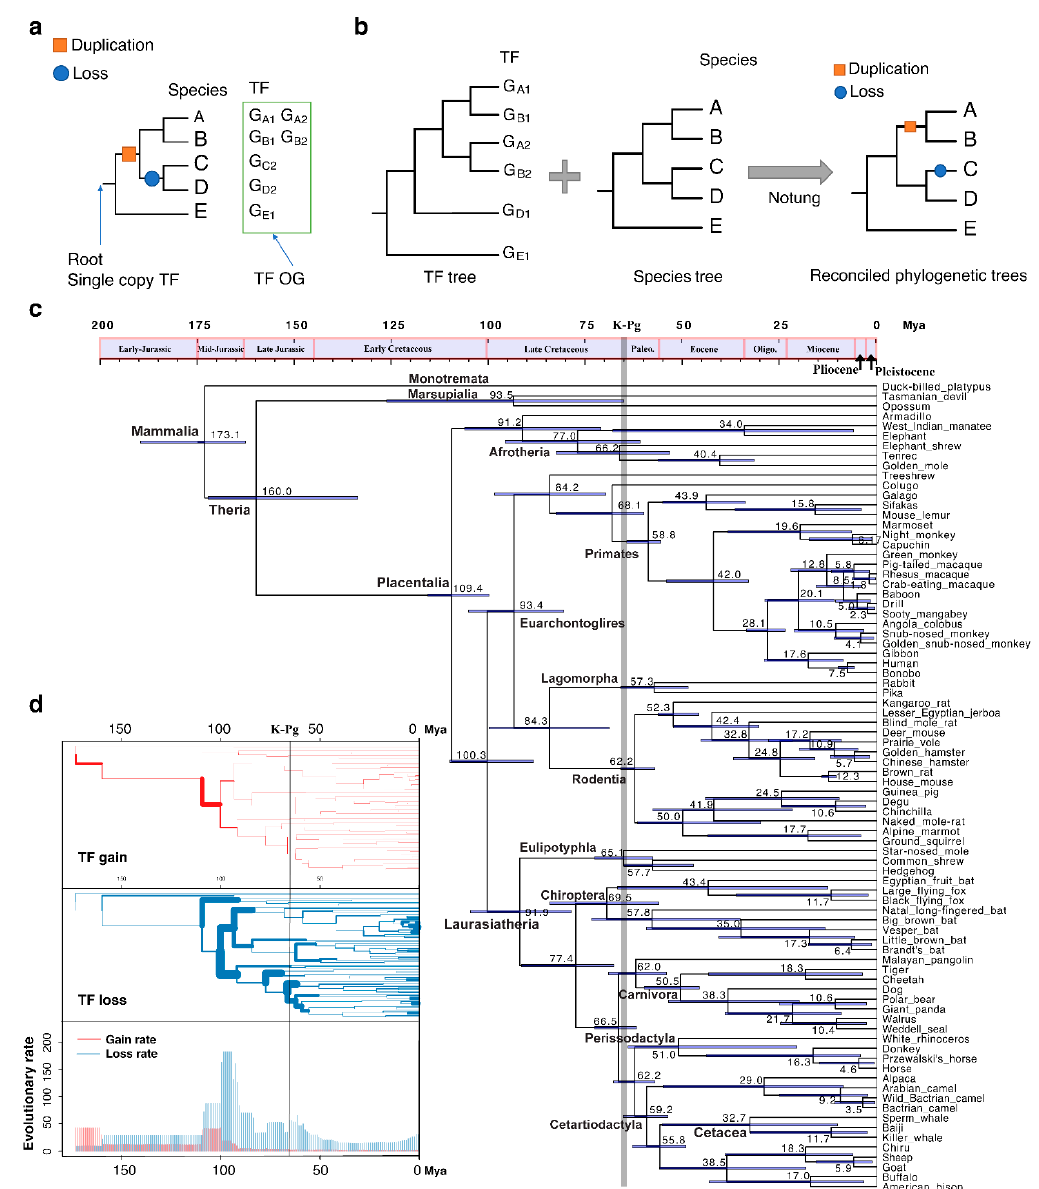
Figure 1. Simplification of transcription factors (TFs) during mammalian evolution using an effective population size of 10 6 . ( a ) A simple example of TF orthologous group (OG). The orange square indicates a duplication event, and the blue circle represents a loss. The genes in the green box belong to the same OG and all originated from the single-copy gene G at the root. ( b ) Inference of duplication and loss by TF-tree–species-tree reconciliation. G, TF genes. A–E, species. ( c ) Time tree of 82 mammals based on protein sequences. Numbers at internal nodes are estimated divergence times (Mya, million years ago), with 95% credible intervals indicated by horizontal bars spanning nodes. ( d ) Atlas of TF gain and loss during mammalian history. The width of each branch is proportional to the rate of TF gain (or loss). The bar plots are mean evolutionary rate (mean TF gain or loss events of each million years).